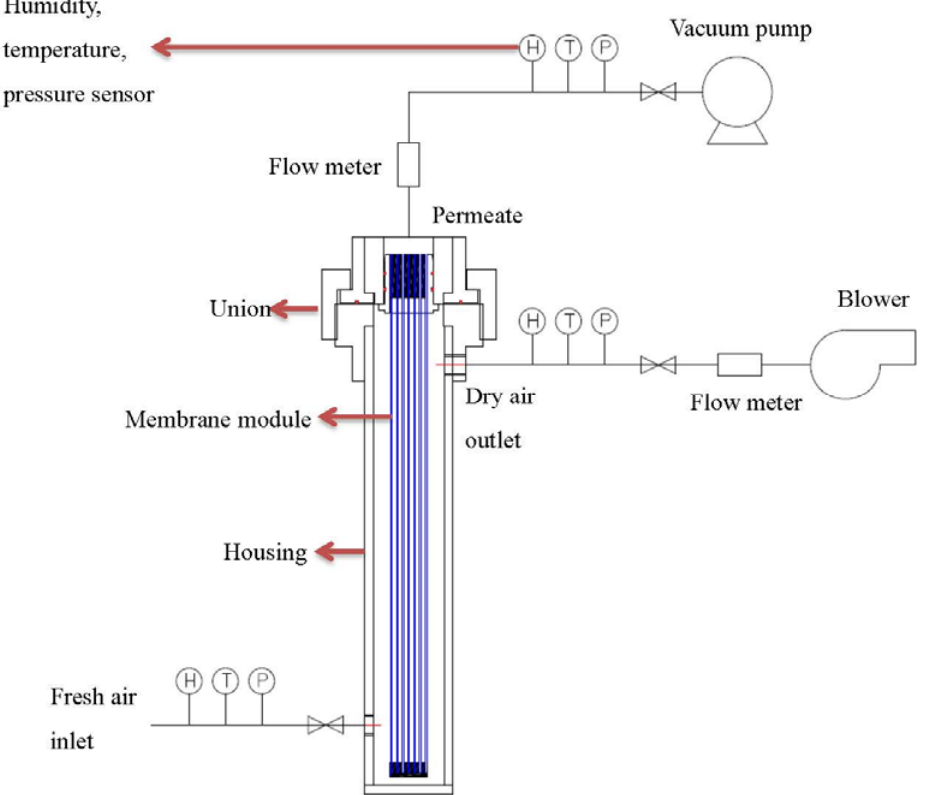
Figure 4. Water vapor test skid of hollow fiber